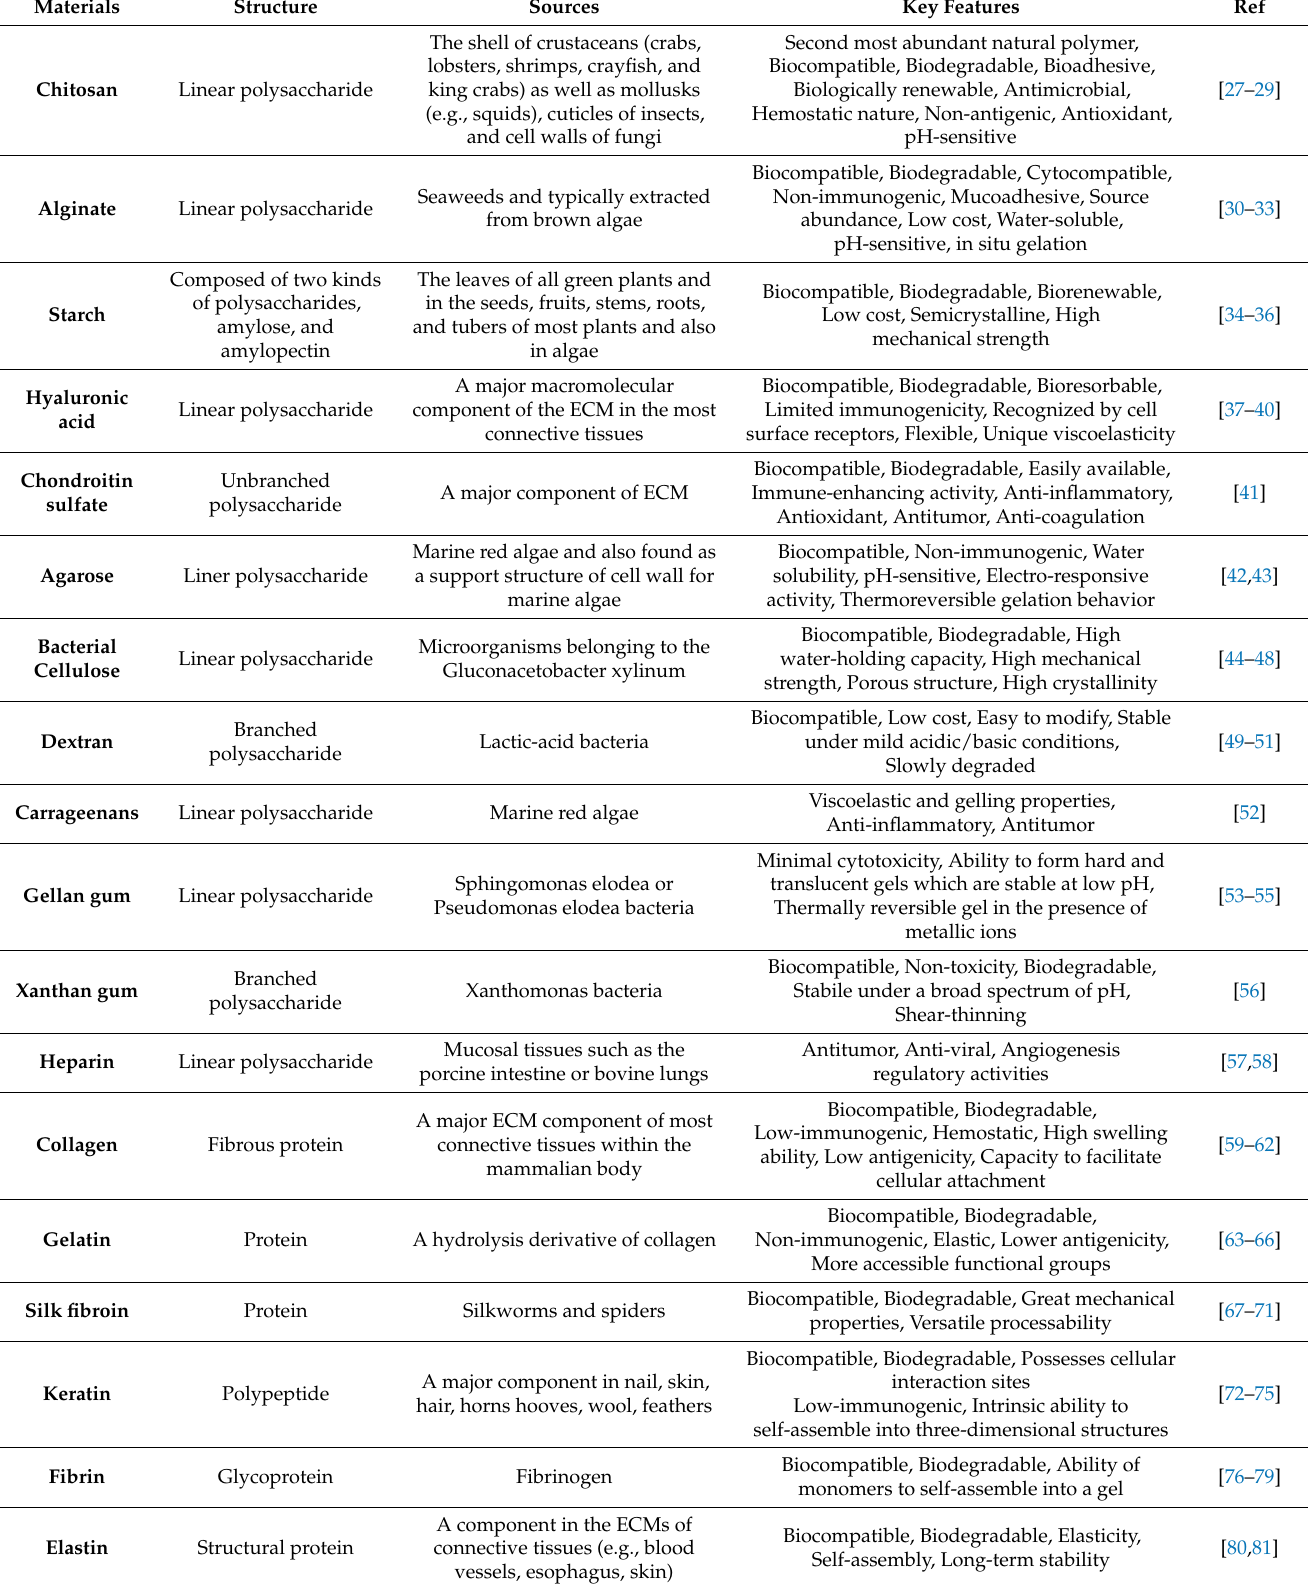
Table 1. Characterizations of the natural polymers used in tissue